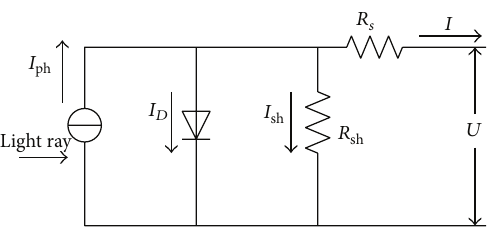
Figure 2: PV cells equivalent